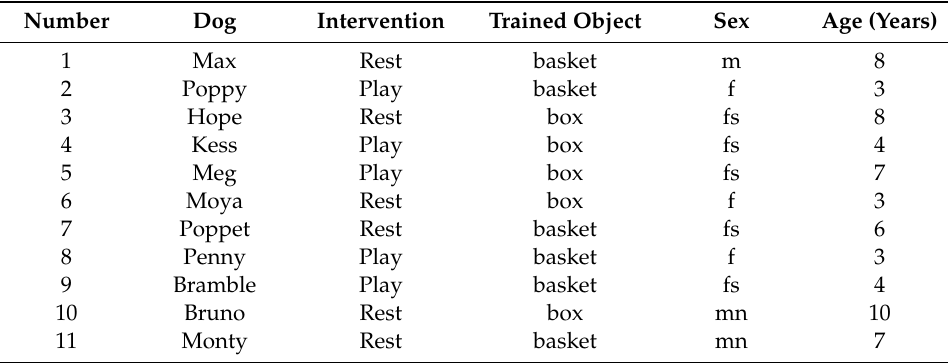
Table 1. Key demographics of the retested individual